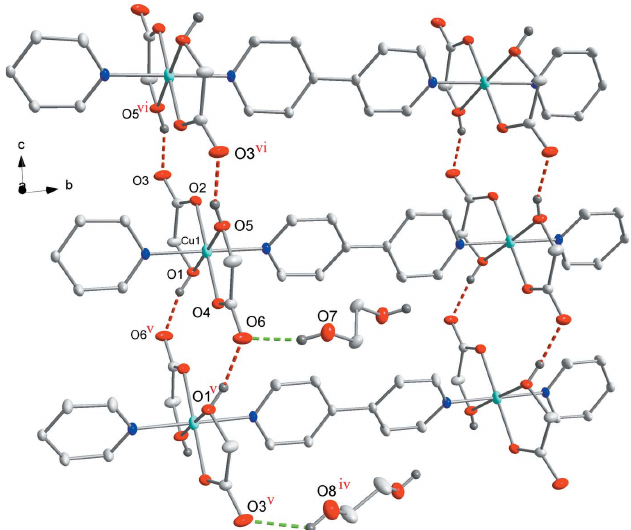
Figure 1 The expanded asymmetric unit of the title complex showing the atom- numbering scheme. Displacement ellipsoids are drawn at the 30% probability level. [Symmetry codes: (i) (cid:5) x + 1, (cid:5) y + 1, z ; (ii) (cid:5) x + 1, y + 1, z ; (iii) (cid:5) x + 1, (cid:5) y + 1, (cid:5) z +